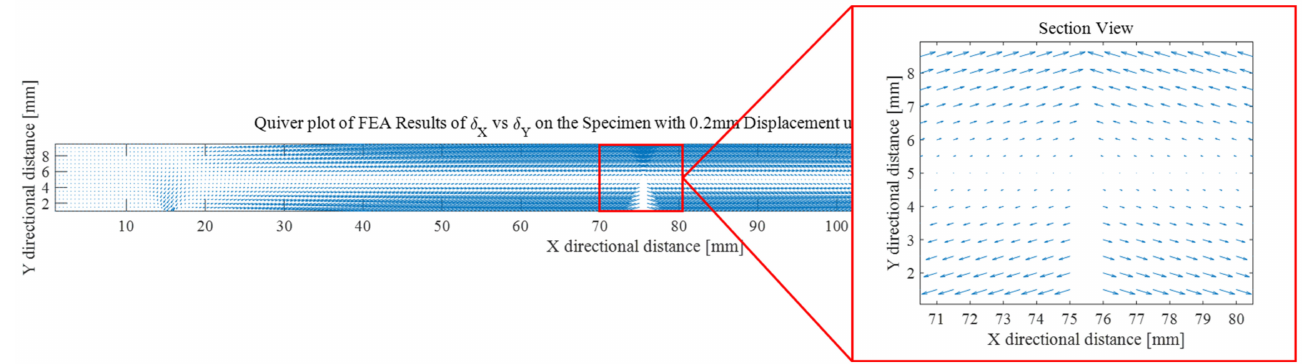
Figure 17. Vector plot of FEA of deflection components in the x ( δ x ) vs. y ( δ y ), on structural simulation of 4-point bending